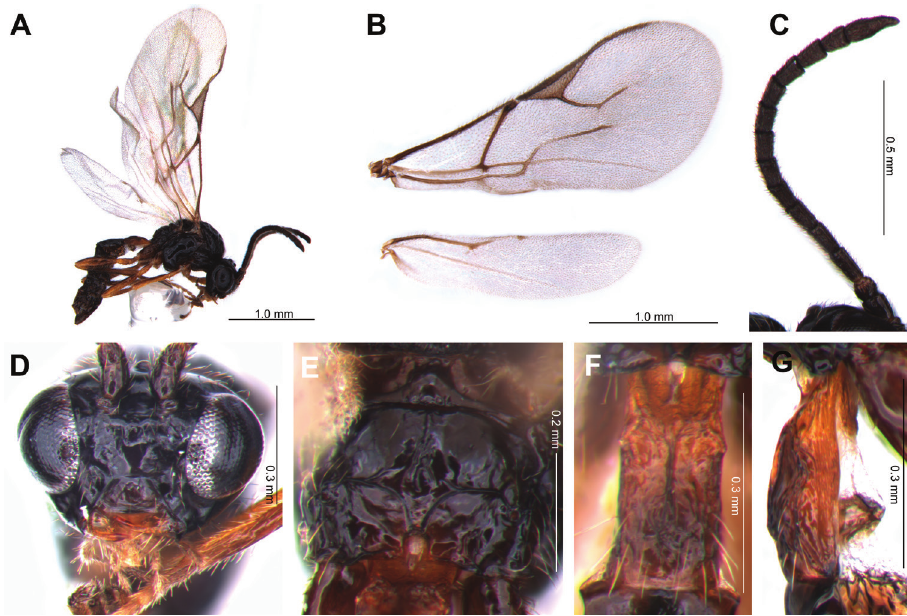
Figure 5. Aphidius areolatus Ashmead, female A body B wing C antennae D head E propodeum F dorsal view of petiole G lateral view of